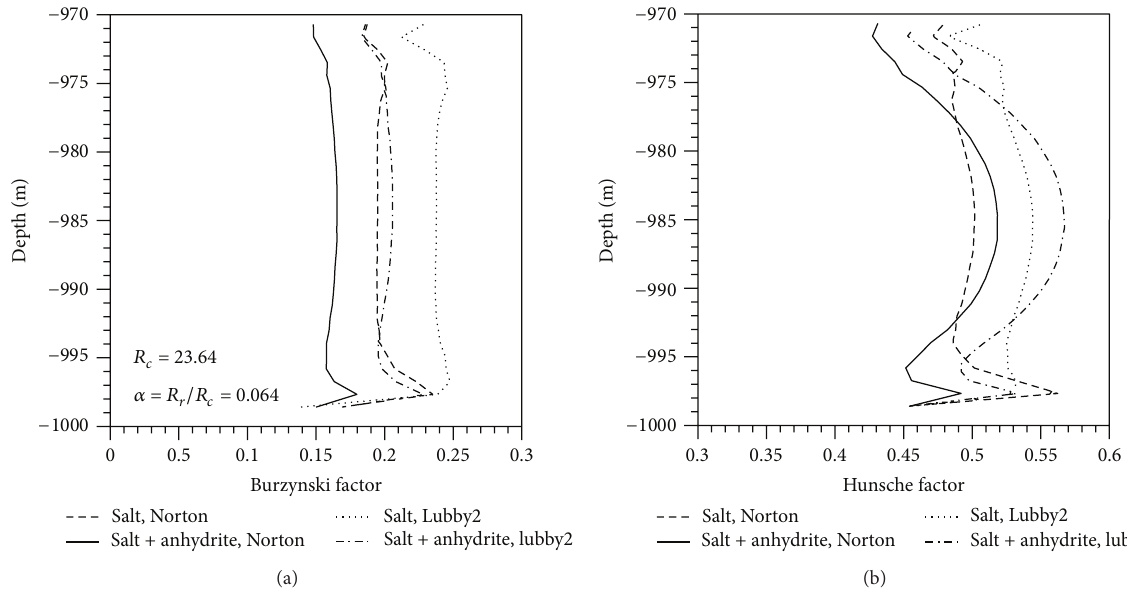
Figure 10: Failure factor according to Burzynski criterion (a) and to Hunsche criterion (b) along the chamber wall for the detector chamber in rock salt [11].